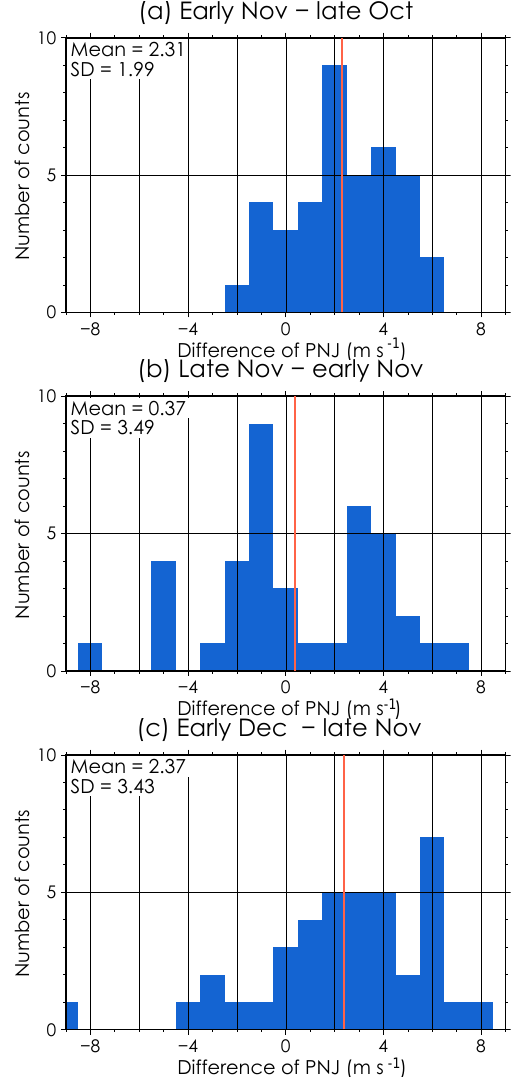
Figure B1. Histograms of the difference of the PNJ in (a) early November and late October, (b) late and early November, and (c) early December and late November (1.0ms − 1 bins). The ver- tical axis indicates the number of counts for each bin. The labels on the upper-left corner show the mean and standard deviation. The orange lines indicate the mean.